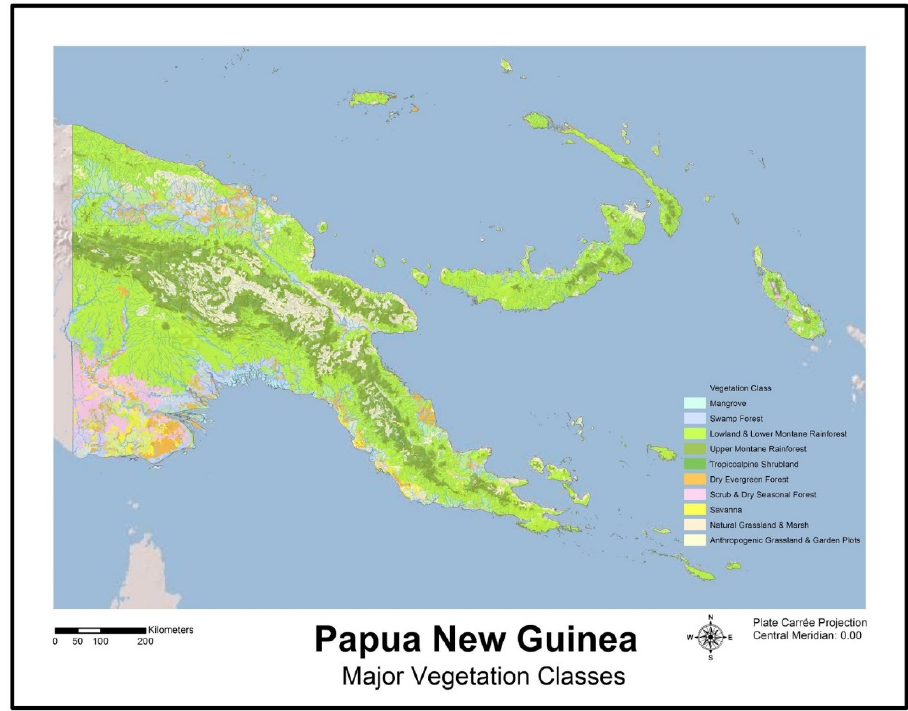
Figure 2. Extent and distribution of the major vegetation classes of Papua New Guinea. Data adapted from the Forest Inventory Mapping (FIM) System, sensu McAlpine and Quilley